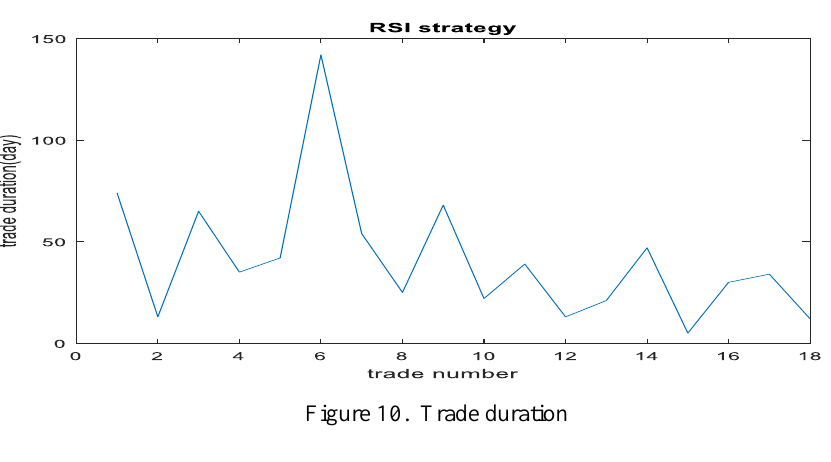
Figure 10. Trade duration